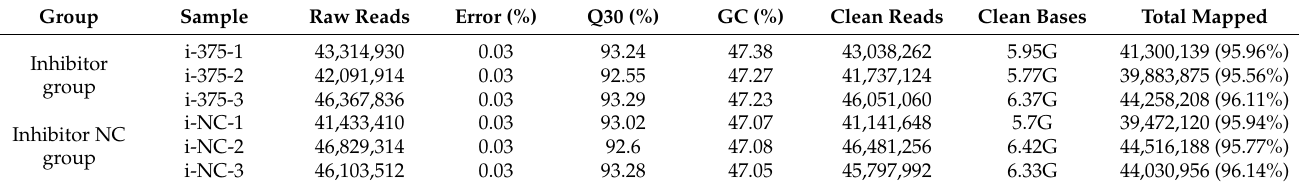
Table 2. Quality assessment and comparison of sequencing data with reference genomes.